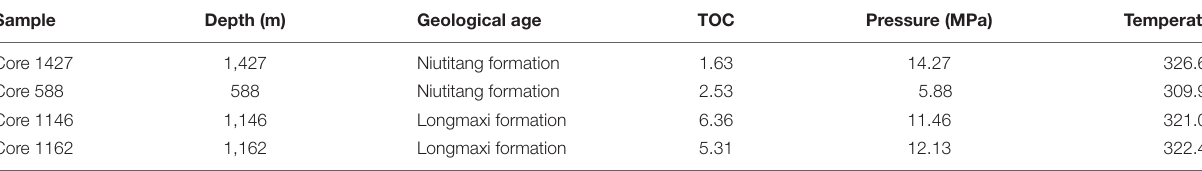
TABLE 1 | Sample inflation compensation standard.